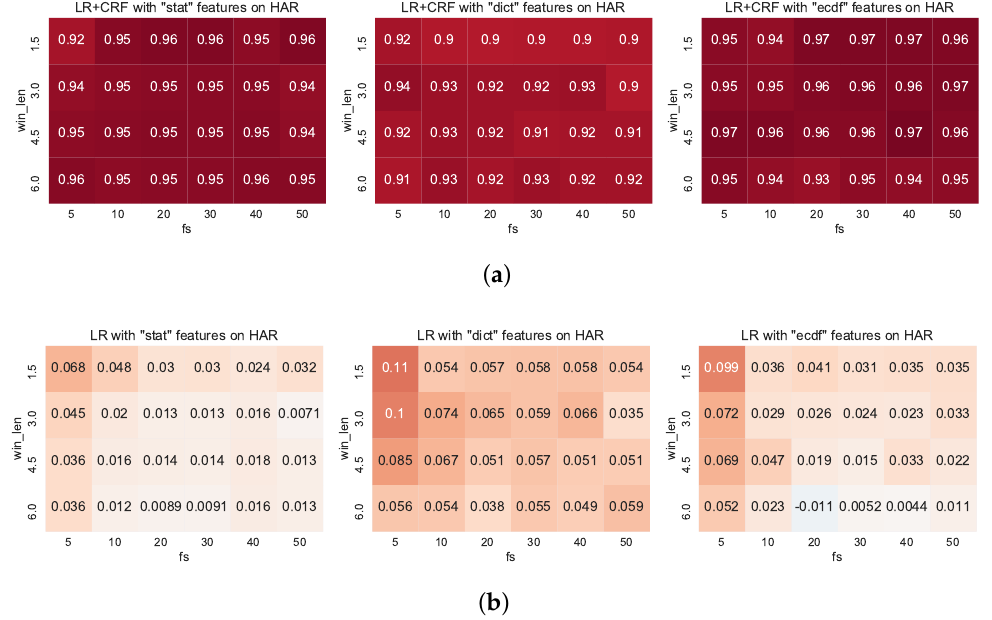
Figure 7. Classification performance obtained by Logistic Regression-Conditional Random Field (LR-CRF) on the HAR dataset. ( a ) LR-CRF classification performance over the three feature categories considered. ( b ) Difference between LR-CRF and LR classification performance. Red indicates LR-CRF outperforms the basic LR